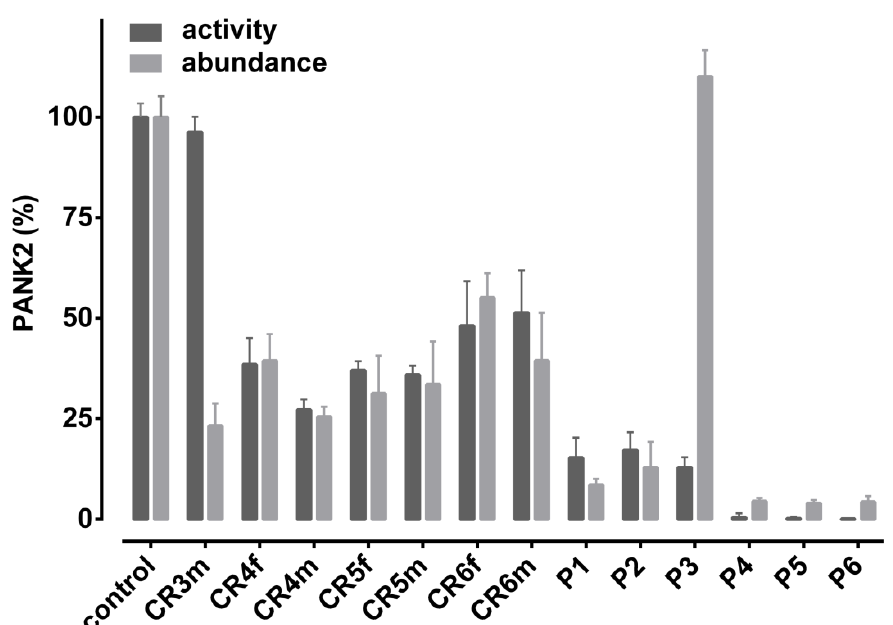
Figure 2. Comparison of PANK2 activity and abundance in erythrocytes of patients affected by PKAN and disease carriers. PANK2 activity and abundance as assessed by a radiometric assay and Western blotting, respectively, are given in percent normalized to that of a healthy control donor, which is set to 100%. Data are derived from Table 2 showing mean values with standard deviations.